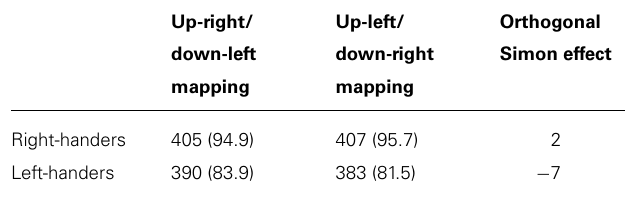
Table 1 | Experiment